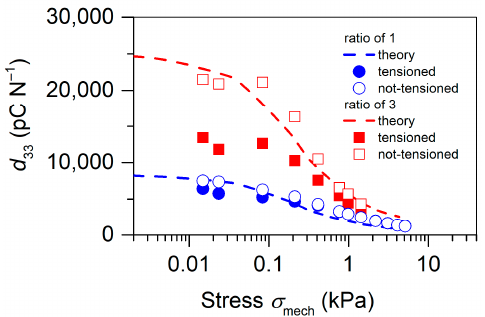
Figure 7. Quasi-static piezoelectric d 33 coefficients versus stress for the alternating FEP/TPU/FEP– FEP/air/FEP sandwiches with different w air ratios as indicated. The symbols represent the experi- w TPU mental results, while the dashed lines correspond to theoretical calculations utilizing Equation (9). The model parameters used are given in the text.